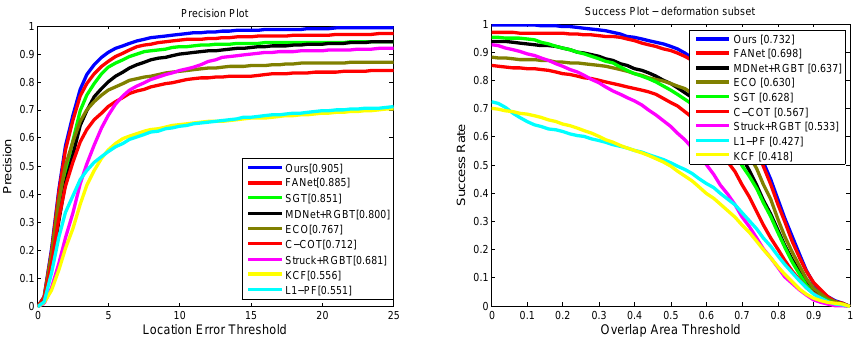
Figure 3. Performance comparisons on the GTOT dataset against state-of-the-art trackers. We construct training data using the full GTOT dataset and train the model on the RGBT234 dataset. We compare the proposed framework with state-of-the-art trackers, including single modal trackers such as MDNet [4], ECO [32], C-COT [33], SOWP [34], SRDCF [35], CSR-DCF [36] and CFNet [37], as well as RGB-T trackers such as SGT [9], FANet [13], MDNet + RGBT, SOWP + RGBT, CSR-DCF + RGBT, L1-PF [15] and CFNet + RGBT. Here, we only display the top 12 trackers. As shown in Figure 4, the SCA- MMA framework performs the best with different evaluation metrics. Compared with the second state-of-the-art tracker, the SCA-MMA framework achieves 80.2%/56.9% in PR/SR and gains a 3.8%/3.7% improvement over the second performance tracker, as well as an 8.0%/7.4% improvement over the baseline MDNet + RGBT.